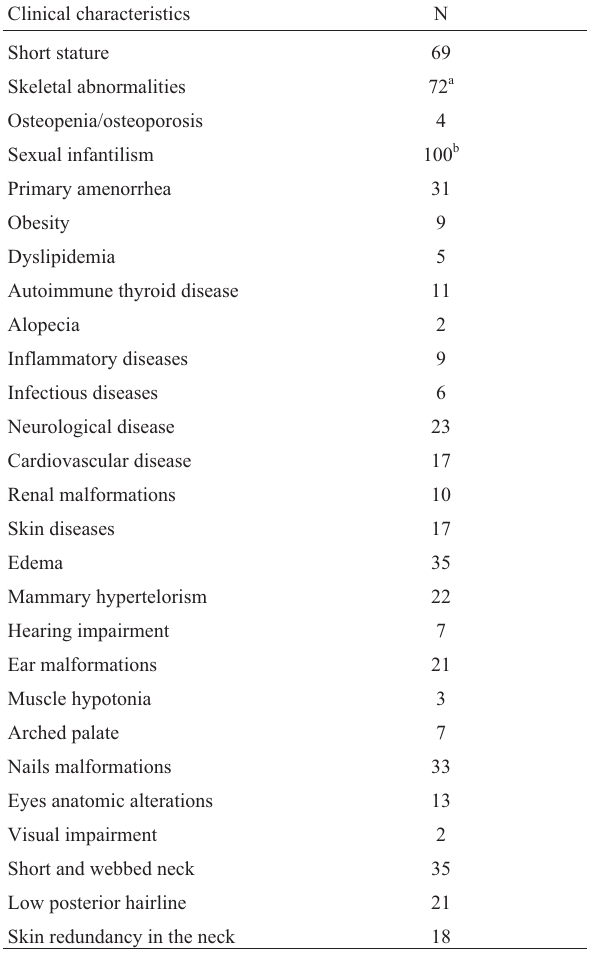
Table 1 - Clinical characterization of all Turner syndrome patients en- rolled in our study. Clinical